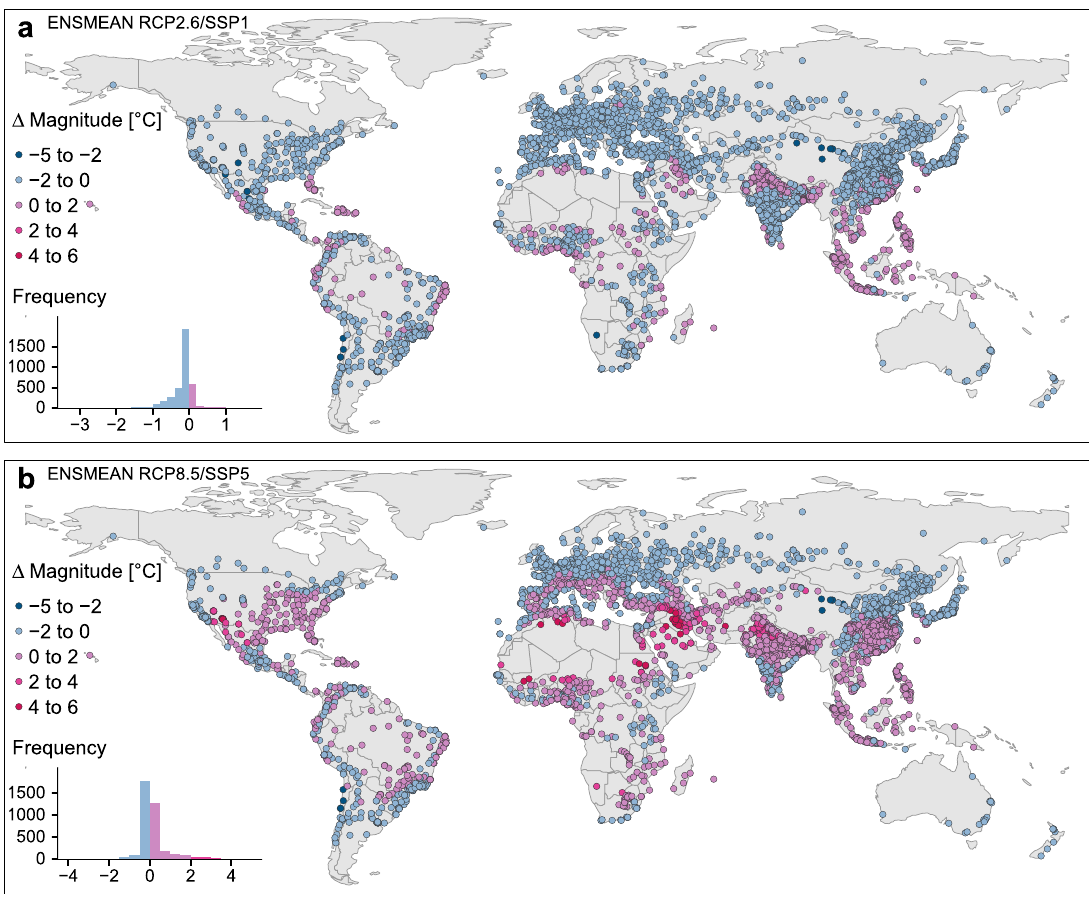
Figure 6. Changes in future heat exposure magnitude in major cities worldwide until 2100. (cid:31) MAG 1991–2000 to 2090–2099 in case of RCP2.6/SSP1 ( a ) and in case of RCP8.5/SSP5 ( b ). (Map created in R (version 3.6.2) 28 using the tmap package (version 2.3-2) 29 ).